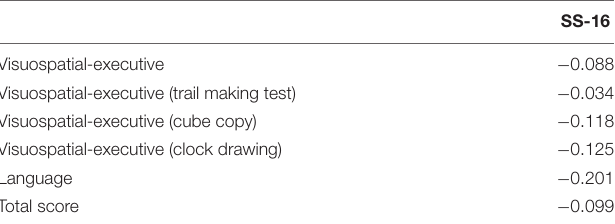
TABLE 6 | Correlation analysis between SS-16 score and MOCA item (visuospatial-executive and language items) score in all participants (correlation coefficient r s ).